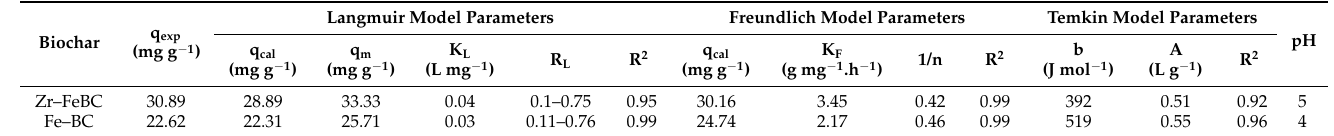
Figure 3. Effect of equilibrium concentration on adsorption capacity of P ( A ), Isotherm model: Langmuir linear model ( B ), Freundlich linear model ( C ) and Temkin model ( D ) (initial P concentration was 5 to 300 mg L –1 , biochar concentration was 2 g L –1 at 22 ± 0.5 °C). Table 3. Model parameters of adsorption isotherms for P